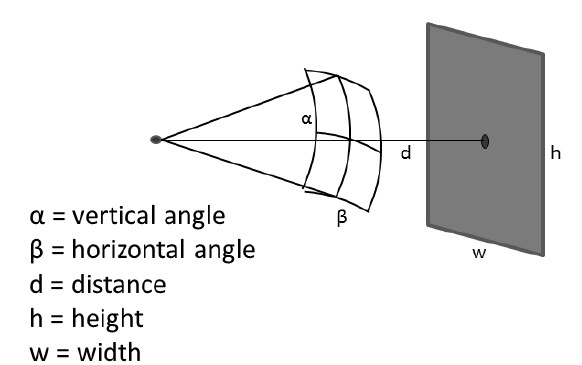
Figure 1: Measuring size of a viewed object by its angles in the observer’s